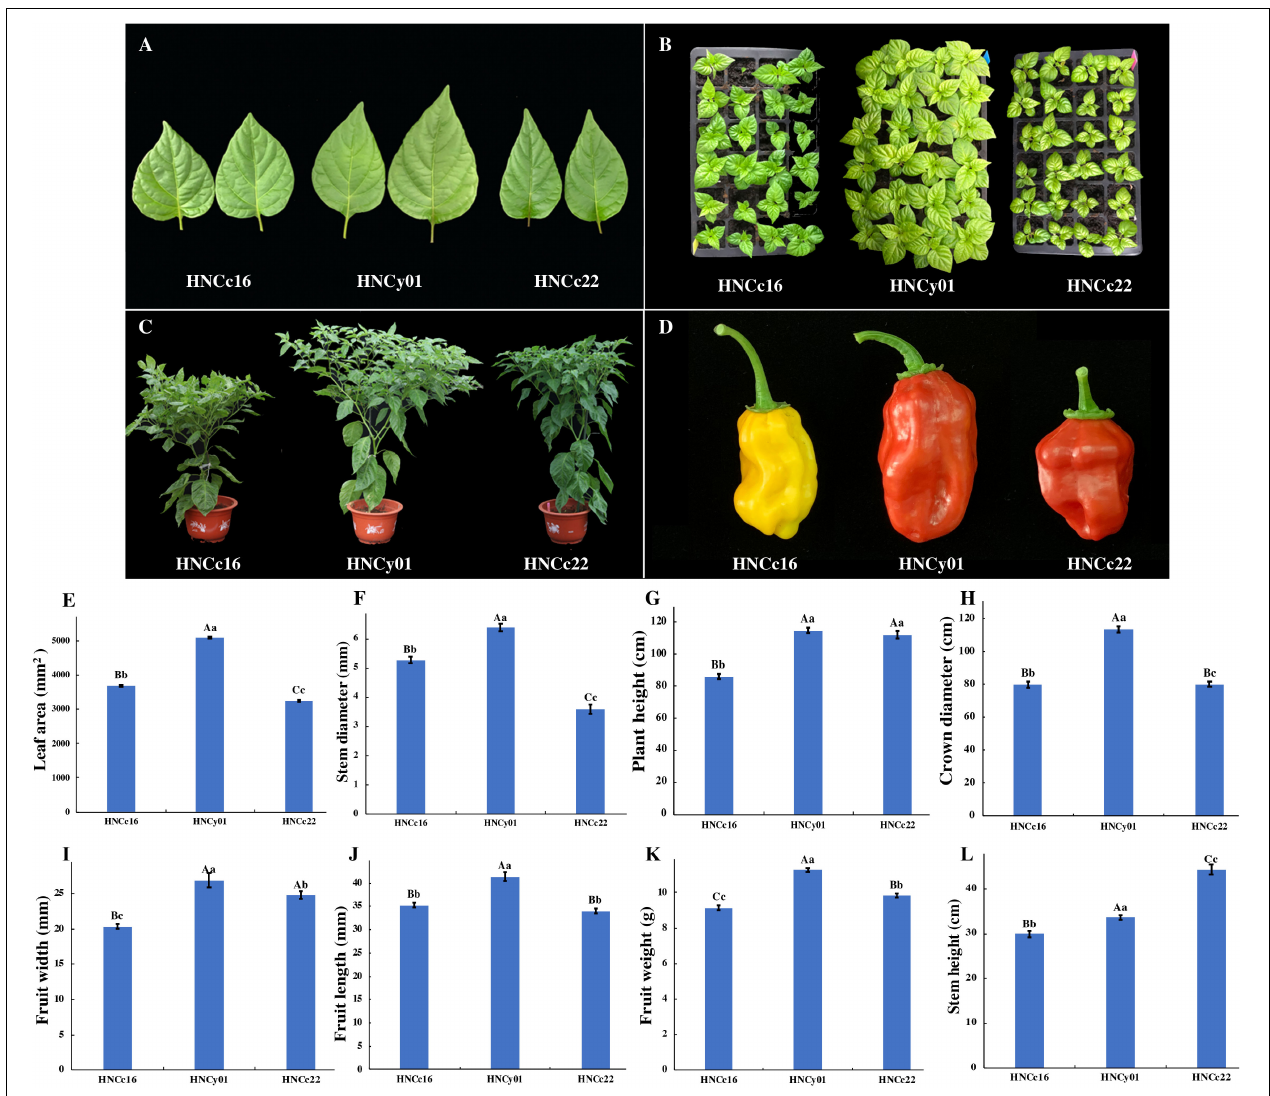
FIGURE 1 | The growth of the F 1 hybrid and its pepper parents at the S-stage and F-stage. (A) Leaves from F 1 , HNCc22, and HNCc16 at the S-stage. (B) Plants of the F 1 and its parents at 35 days after germination. (C) Plants of the hybrid and its parents at F-stage of 70 days after germination. (D) The fruit of the hybrid and its parents. (E,F) Plant LA and stem diameter of the hybrid and parents at the S-stage. (G–L) Plant height, crown diameter, fruit width, fruit length, fruit weight, and stem height of hybrid and its parents at the F-stage. Different letters above the columns of bars indicate significant differences at p -value less than 0.05 (lowercase letters) or less than 0.01 (capital